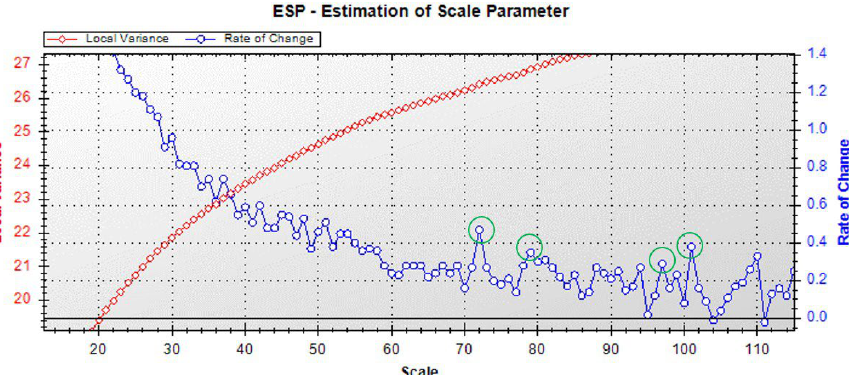
Figure 3. An evaluation of the scale parameters of the multi-scale segmentation algorithm for Shenxiantang. Graphs described changes in local variance (LV) (hollow red) and rate of change (ROC) (hollow blue) with increasing scale parameter. Four green circles are alternative optimal segmentation scale parameters (72, 79, 97 and 101).